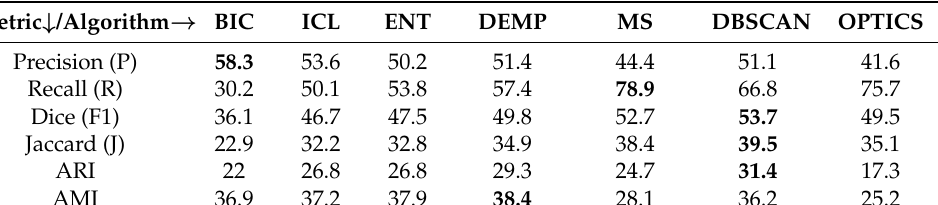
Table 4. Averaged metrics obtained with the Berkley image segmentation dataset. The best values are in bold.